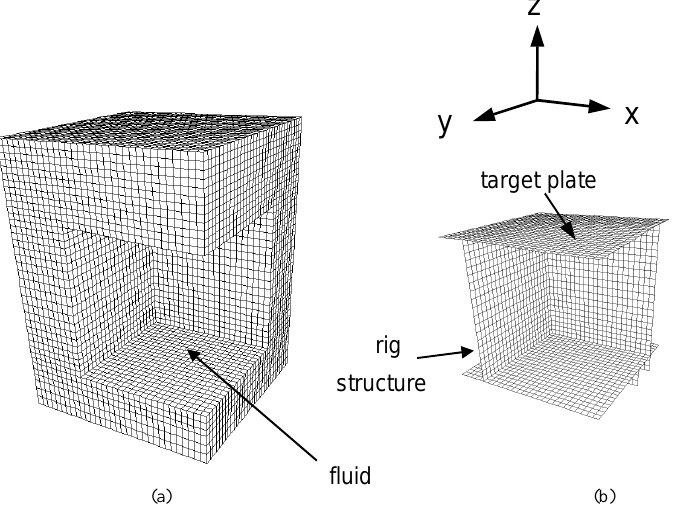
Fig. 4. Hydrostatically initialised, quarter-symmetry, finite element meshes for the (a) fluid volume surrounding the shock rig and (b) the shock rig itself.